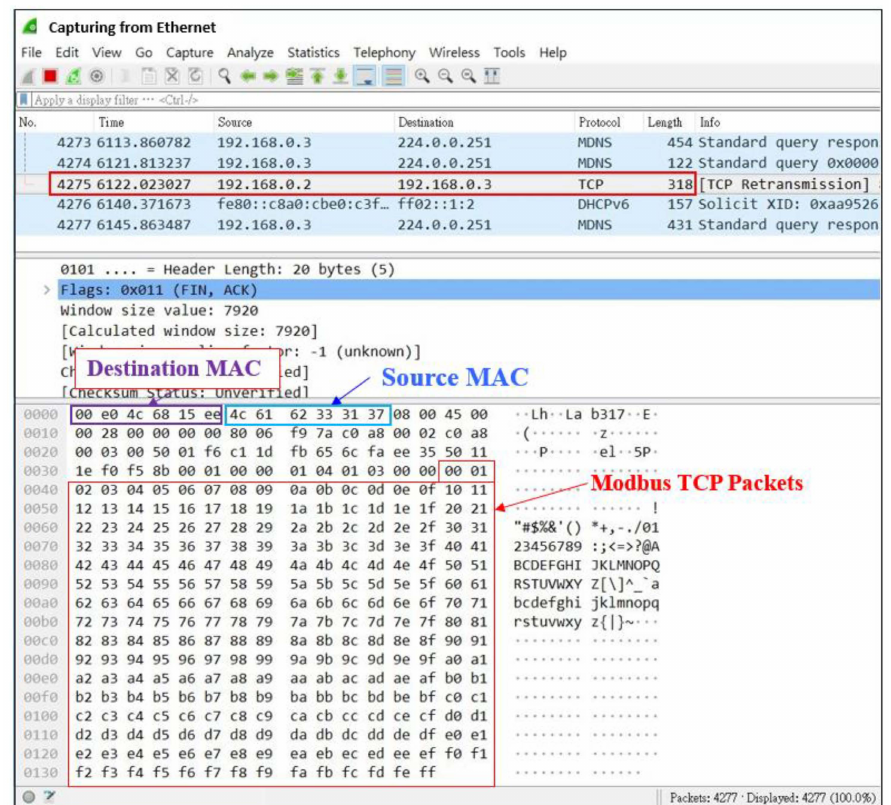
Figure 19. Received Modbus/TCP packets from the FPGA development kit to PC2.